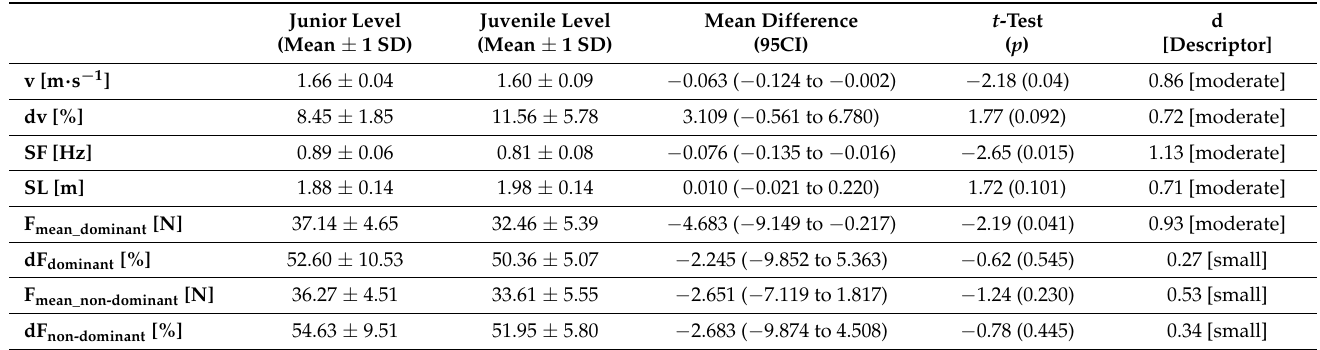
Table 1. Descriptive data (mean ± one standard deviation) of all variables assessed for the two groups and the kinematics and propulsion comparison between